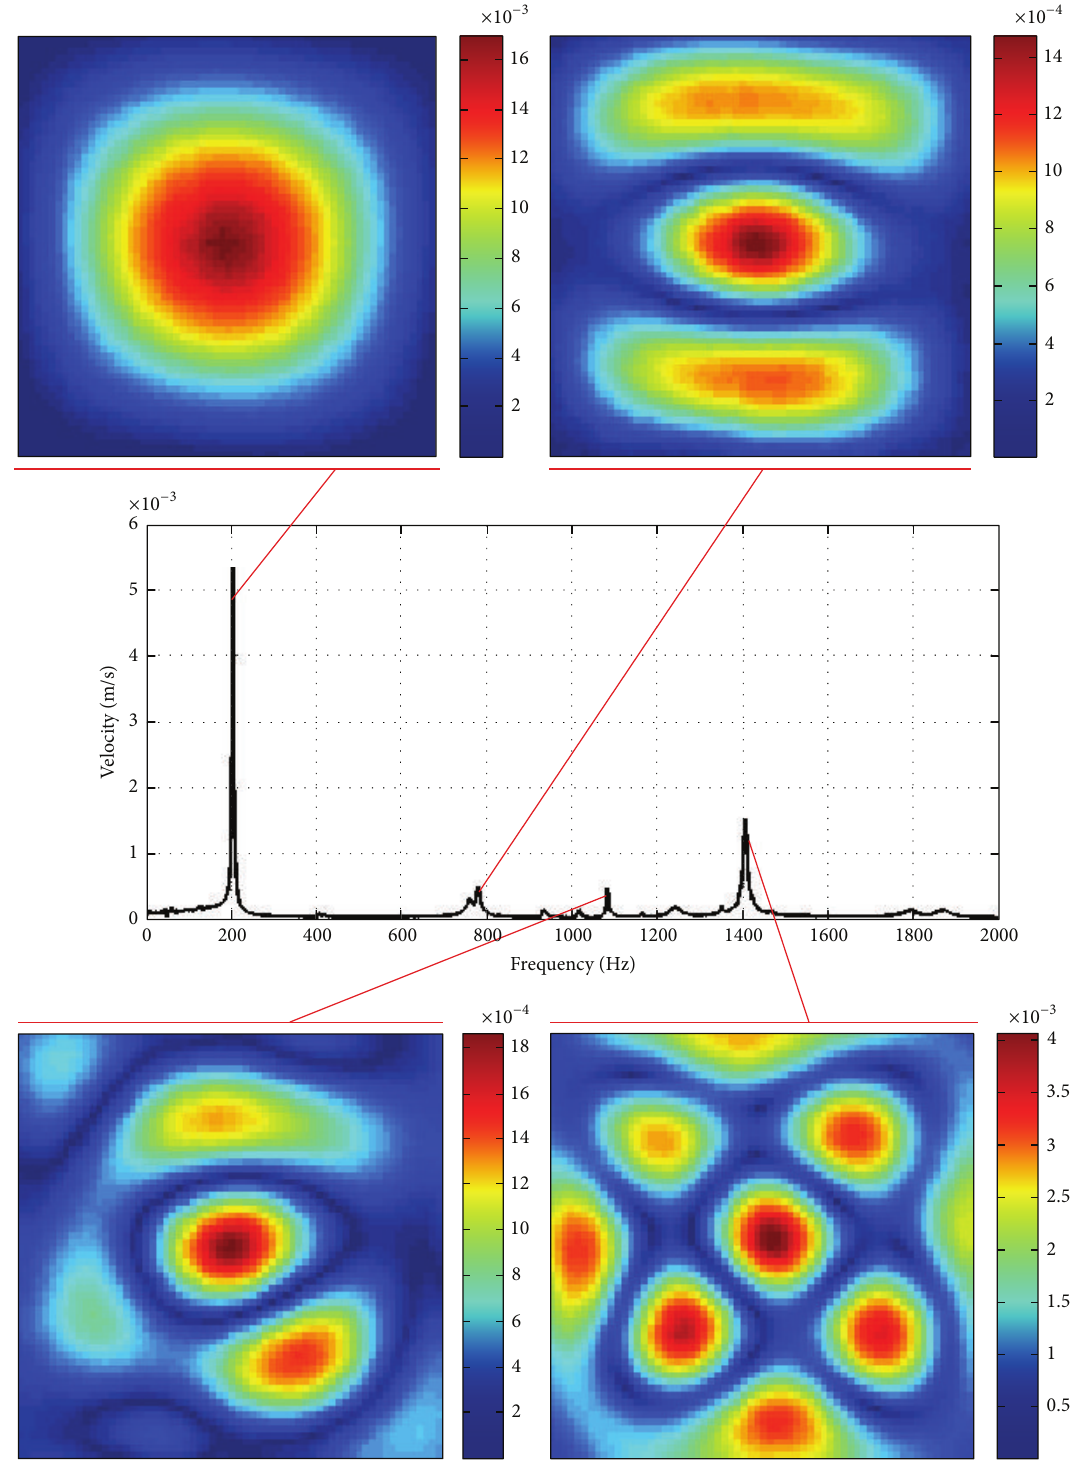
Figure 4: Exemplary FRF and selected modal shapes for the